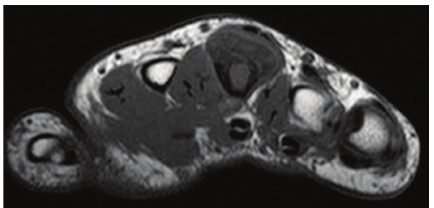
Figure 7: On an axial T1-weighted preoperative MR image of the area, the lesion is composed predominantly of central signal isointense to that of the normal bone marrow with a thin low signal periphery consistent with the cortical bone. Direct continuity with the underlying marrow of the bone is not noted.